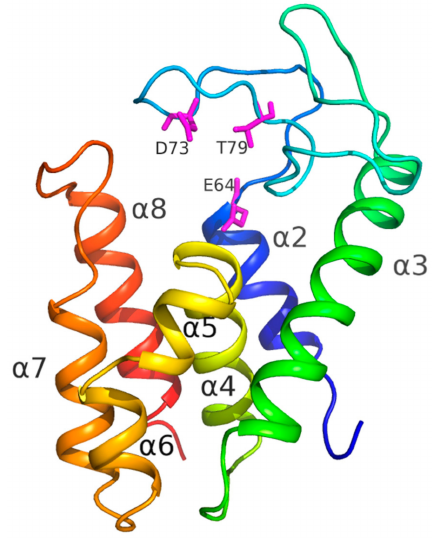
Figure 5. AcLys monomer. Molecule is colored in rainbow manner from blue on N-termini to red on C-termini. Secondary structure elements are captioned as well as the active site residues